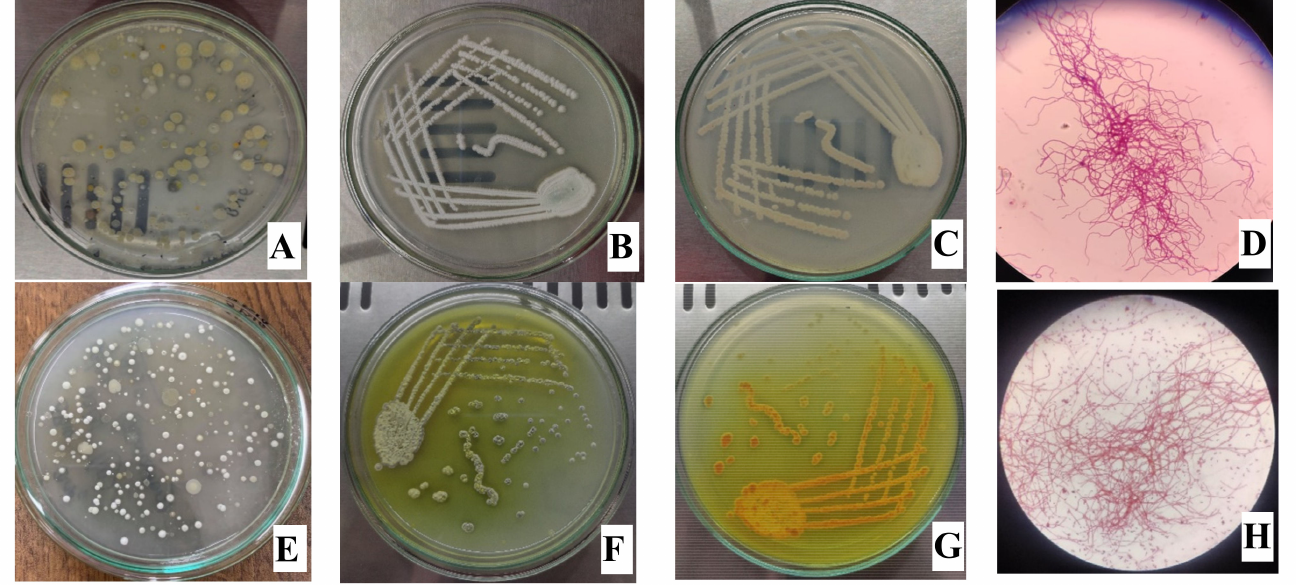
Figure 2. Isolation plate ( A , E ), aerial mycelium ( B , F ), substrate mycelium ( C , G ), and Gram-staining ( D , H ) of BN6 (first row) and BN14 (second